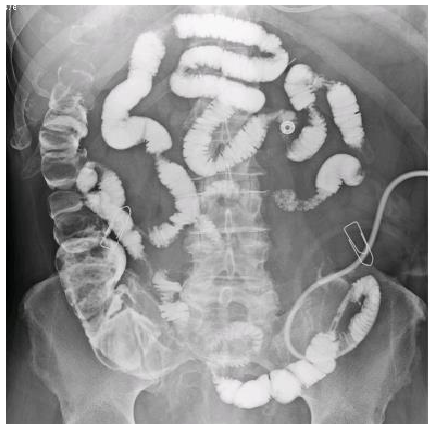
Figure 2. Example of distal bowel opacified by the chyme reinfusion tube inserted 25 cm from the downstream enterostomy (designated by a paper clip). The length was greater than 250 cm. On the right flank, the paper clip refers to the terminal transverse colostomy.